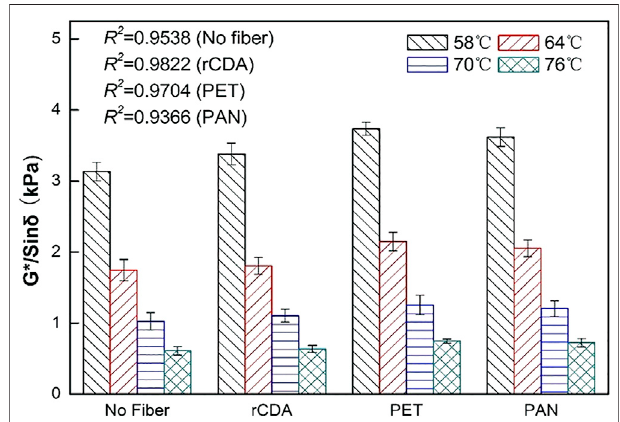
FIGURE 4 | Rutting factor for asphalt mortars with different fi bers by dynamic shear rheometer.